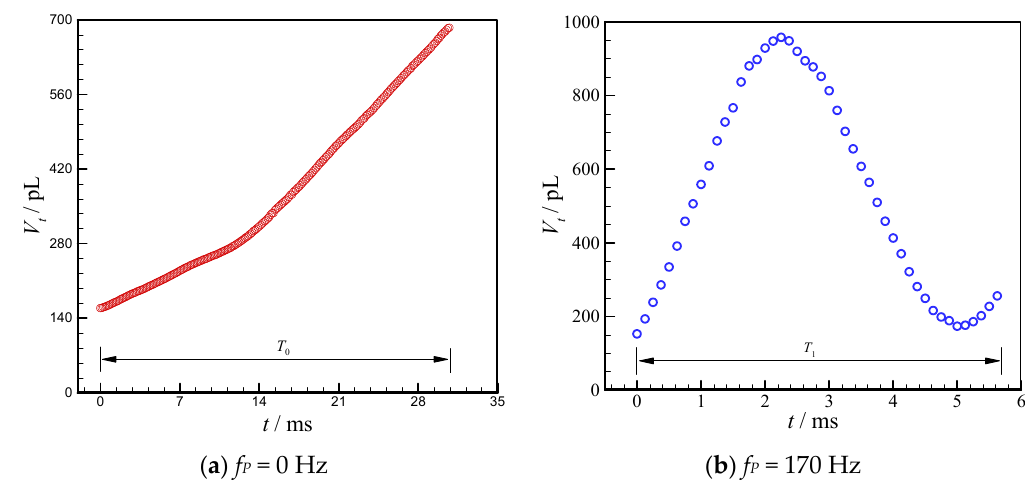
Figure 10. Evolution of dispersed thread head volumes with time during droplet generation without/with external mechanical vibration. ( Q c = 60 μ L/h and Q d = 60 μ L/h.).